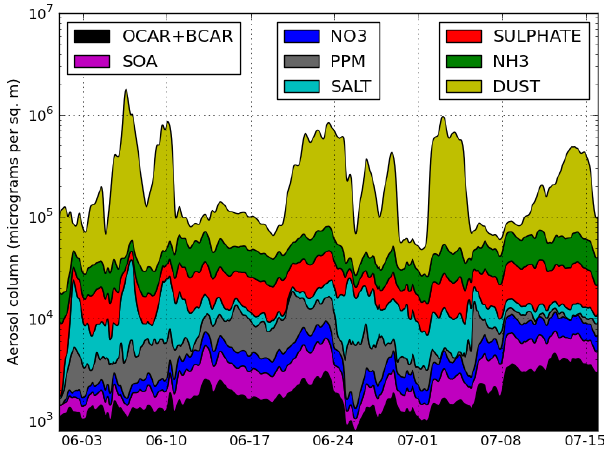
Figure 11. Cumulative plot of the total aerosol mass load (µgm − 2 ) for the following groups of species: organic and black car- bon (OCAR + BCAR), secondary organic aerosols (SOA), nitrates (NO 3 ), primary anthropogenic particulate matter (PPM), sea salt (SALT), sulfate, ammonium (NH 3 ) and mineral dust (DUST).